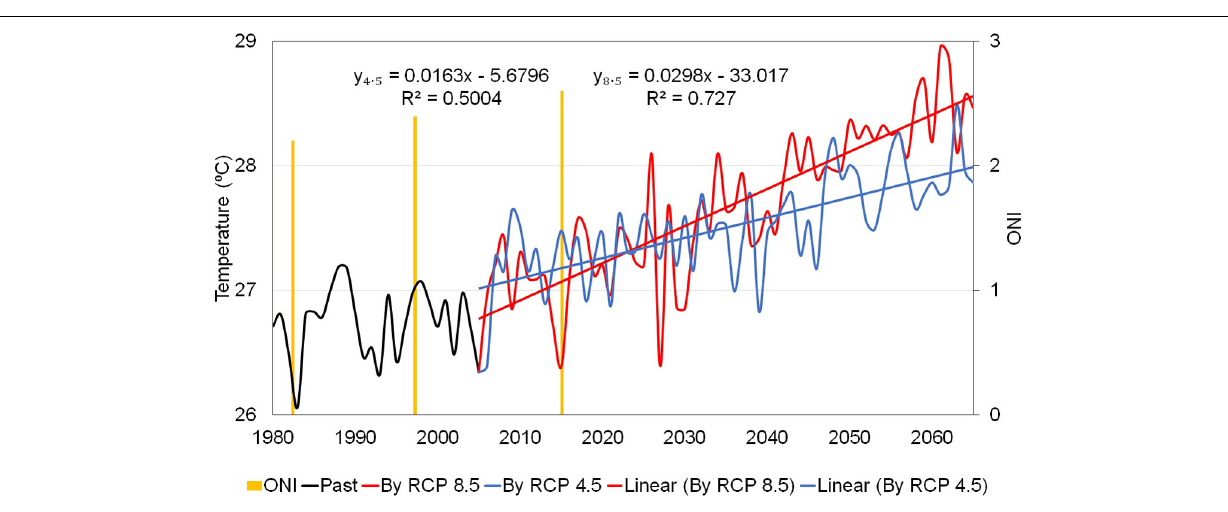
FIGURE 4 | Modelled historic and future annual average sea surface temperature, showing a linear fit to the trend for 2005–2060 under RCP 4.5 (blue) and RCP 8.5 (red). The Oceanic Nino Index for years with strong and powerful El Nino is shown by